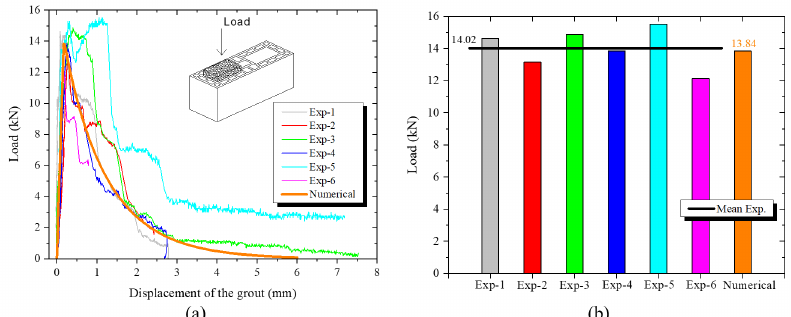
Figure 10. Validation of numerical results of the ClG30 series of push-out tests: (a) force vs displacement diagrams and (b) mean maximum load.